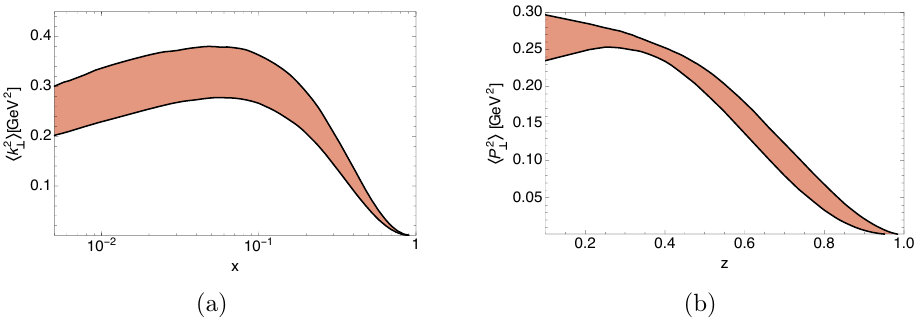
(cid:10) (cid:11) (cid:10) (cid:11) k 2 ( x ) (a) and of P 2 ( z ) (b). The bands are the 68% ? ?